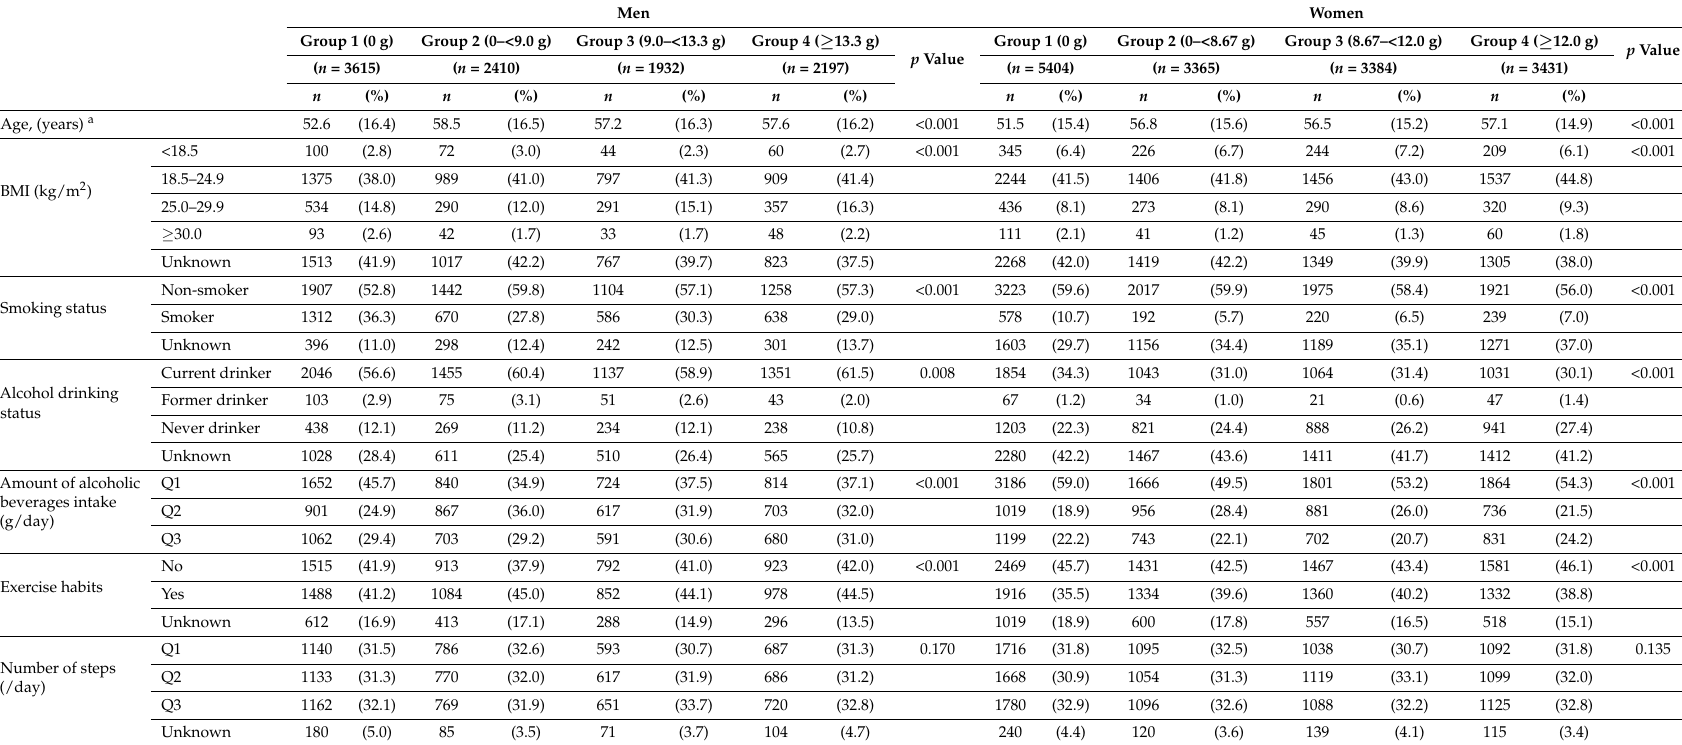
Table 2. Demographic characteristics of the participants according to the portion size of